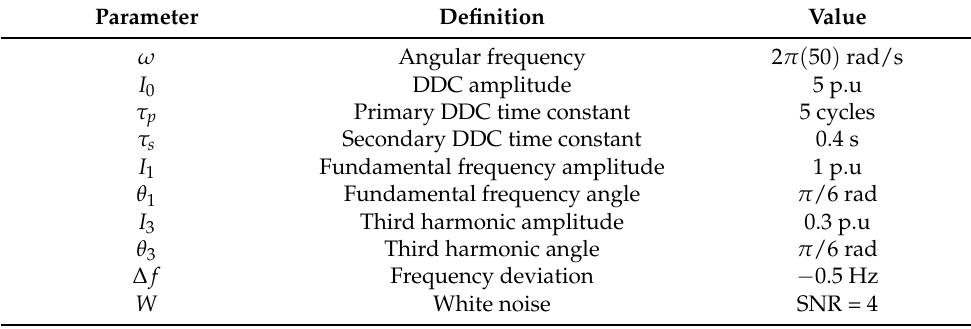
Table 1. Simulation parameters for the FC signal and DDC